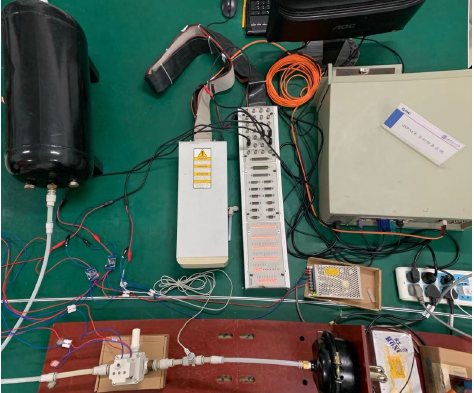
Figure 8. Test bench setup. The proposed MPC controller with the Kalman filter was performed on the test bench based on dSPACE. Under the target pressures of 2 bar, 3 bar, and 4 bar with the supply pressure of 5.8 bar, the comparison results between the simulation data and the experimental data are shown in Figure 9.